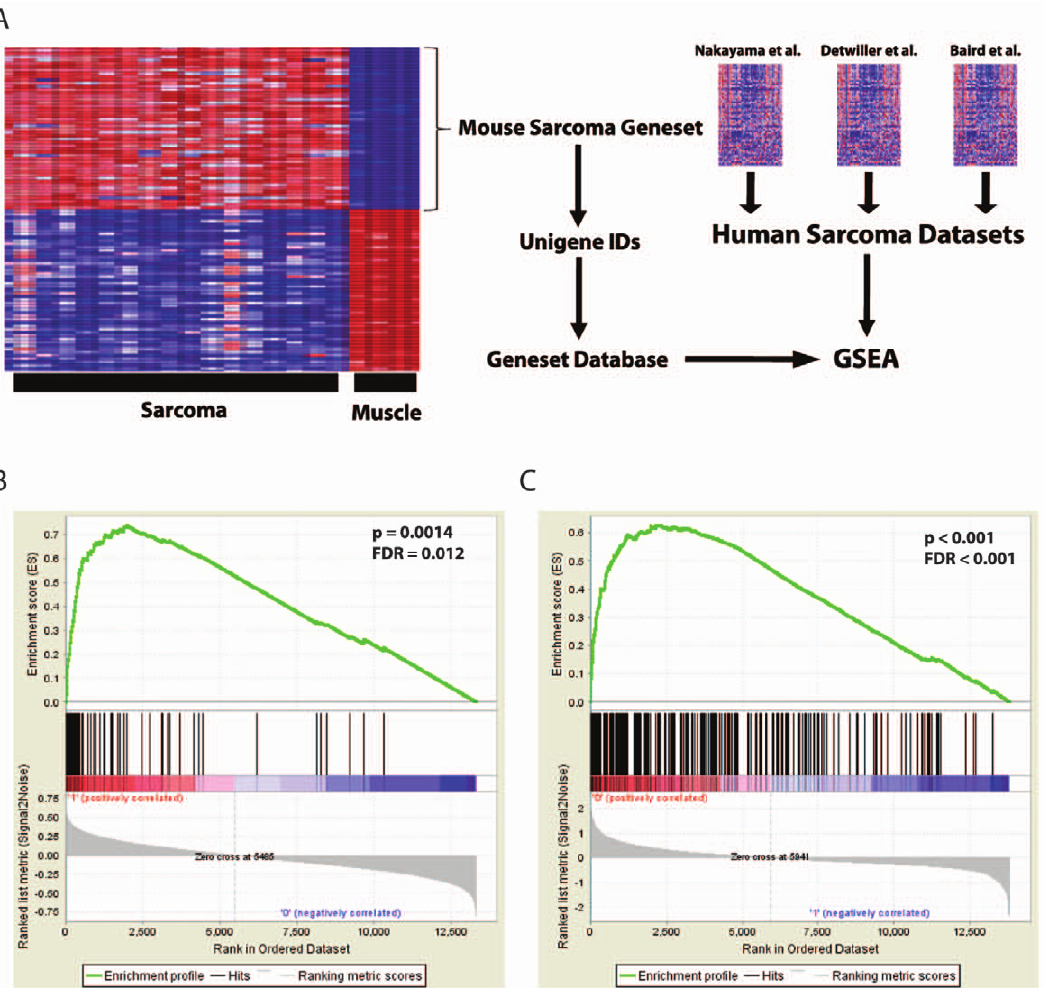
Figure 1. Cross-species genomic comparison. A , Schematic for cross species genomic comparison using GSEA. B , The LSL-Kras G12D ; Trp53 FloxFlox sarcoma geneset (Table S3) is highly enriched in human MFH in the Nakayama et al. soft tissue sarcoma dataset [10] [p=0.0014; False Discovery Rate (FDR)=0.012; Enrichment Score (ES)=0.74; Normalized Enrichment Score (NES)=2.09]. C , Conversely, a human MFH geneset (Table S4) is strongly enriched in the mouse model of soft tissue sarcoma (p , 0.001, FDR , 0.001, ES=0.637 NES=2.78).